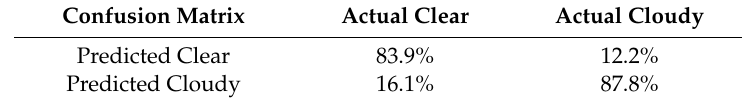
Table 2. Confusion matrix for optimal RF configuration on the independent test dataset and a cloud fraction threshold of 0.40.